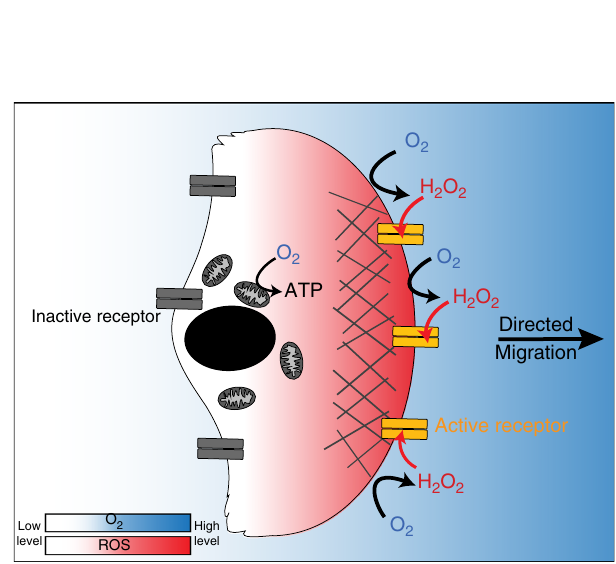
Fig. 7 Model of directed migration of mammary cells in oxygen gradients. Mitochondrial respiration generates hypoxia and an oxygen gradient that in turn generates a ROS gradient since oxygen is required for ROS production. At the cell level, these ROS, that are likely more abundant at the front